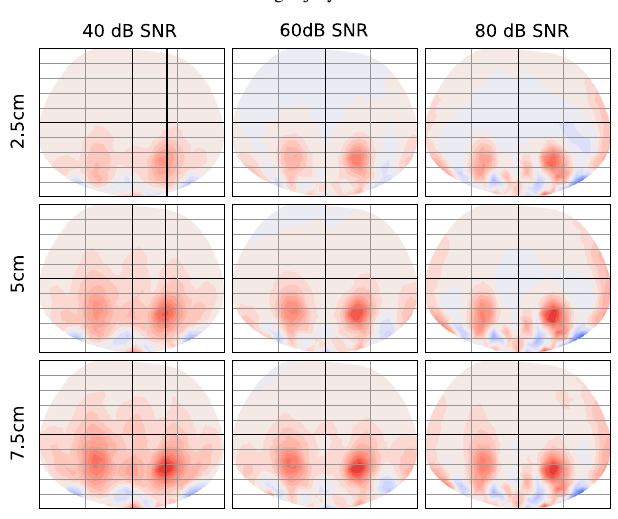
Fig.8: The left column shows the lung function with different levels of lung collapse occured in both lungs simultaneously. The middle and right columns represent, respectively, the cases that the collapse occured in the left lung and right lung only. The rows denote different levels of lung injury.